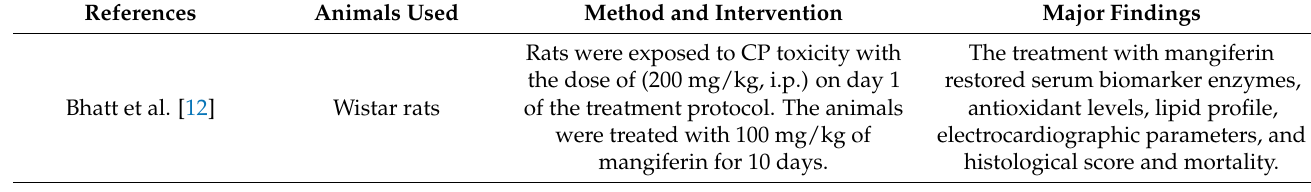
Table 2. Role of medicinal herbs and their active constituents against cardiac toxicity due to anticancer